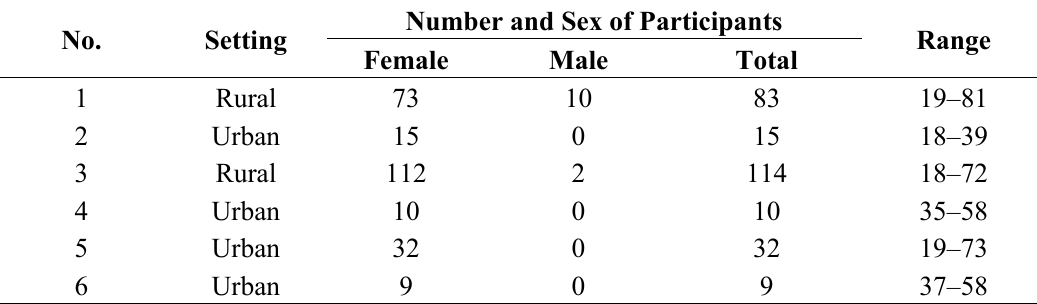
Table 3. Characteristics of Participants of Focus Group